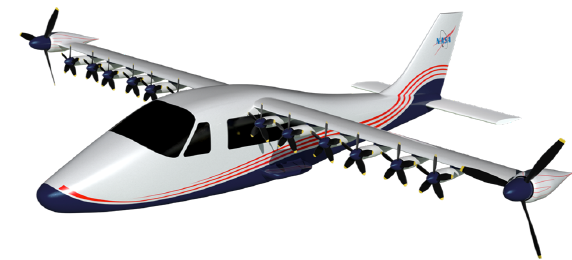
Figure 1. NASA’s X-57 Maxwell aircraft [8].